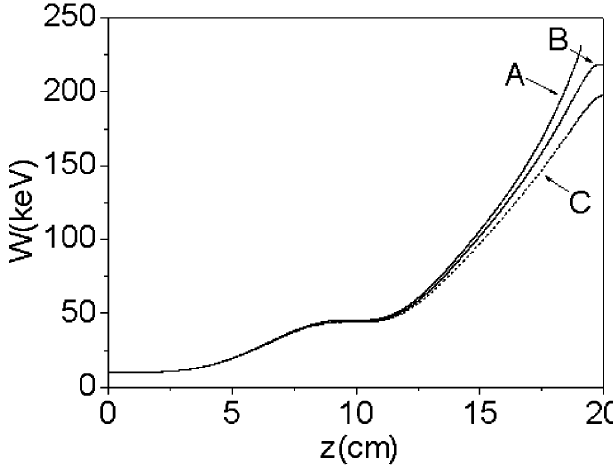
FIG. 4. The electron energy evolution for different radial injection positions: (A) r (cid:1) 1 : 5 cm . (C) r 0